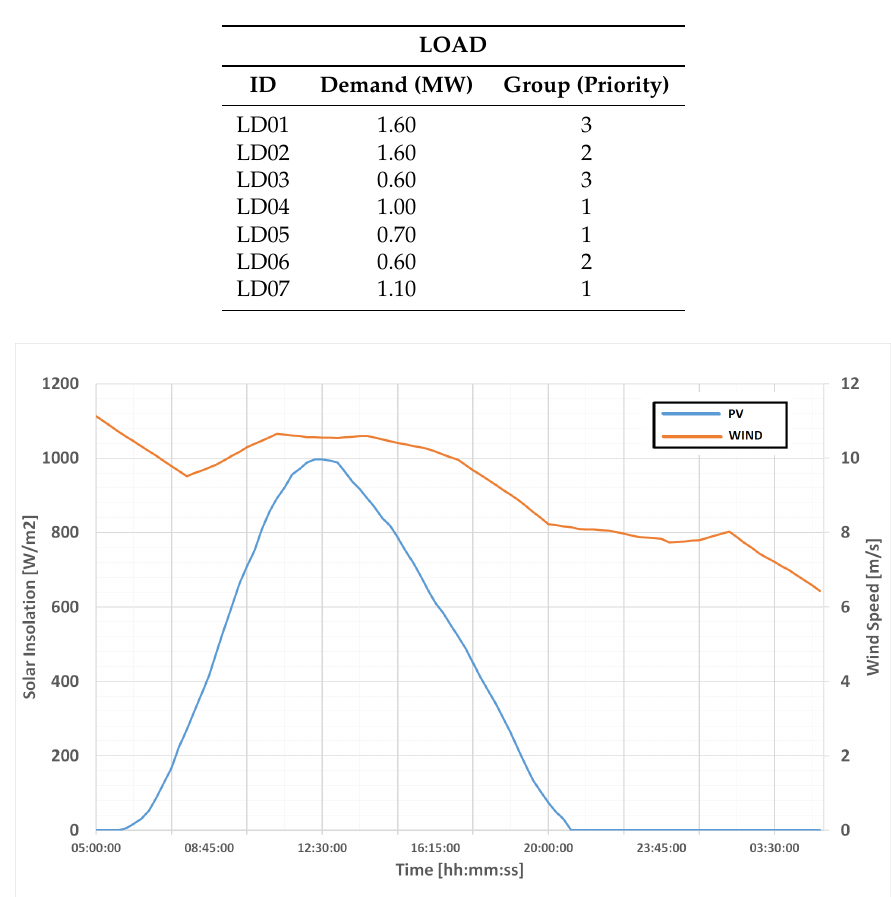
Figure 3. Power Generation Profile for Wind and Photovoltaic